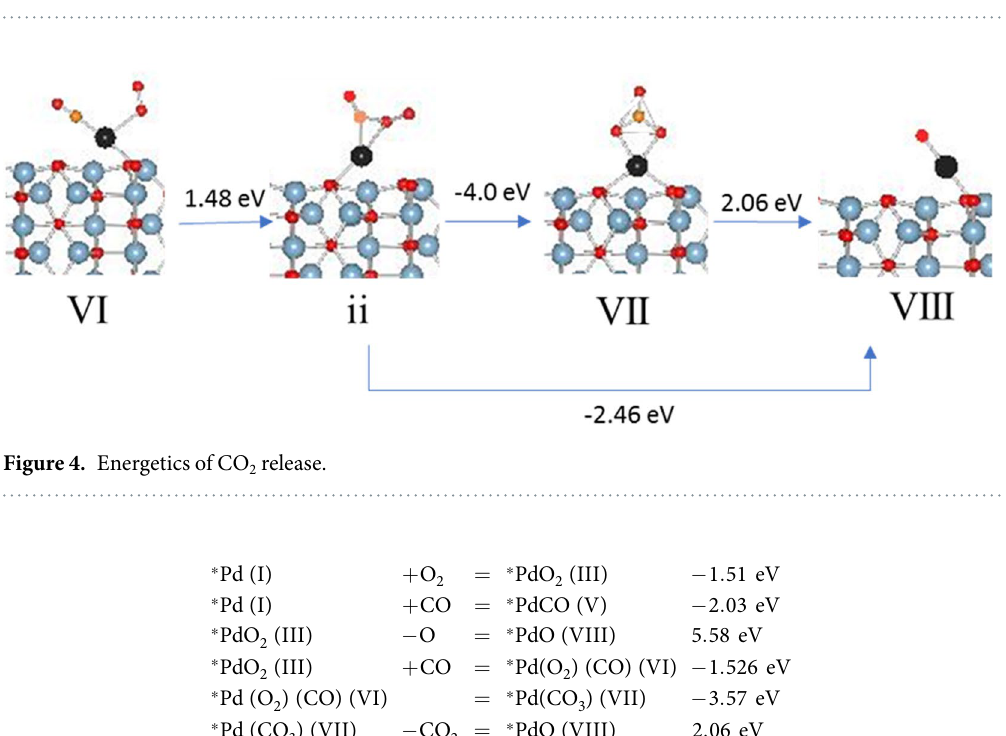
Figure 3. Transition states in carbonate formation over Pd adatom supported on θ -alumina (010) surface.